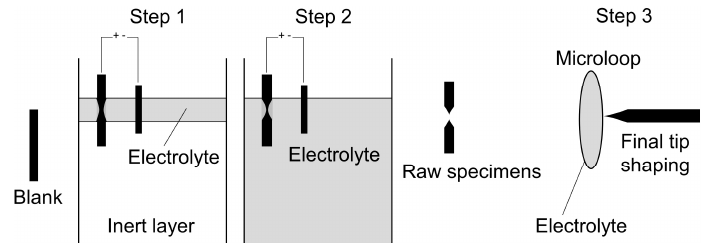
Figure 3. Scheme of the specimen preparation routine by electropolishing. The sample material is cut